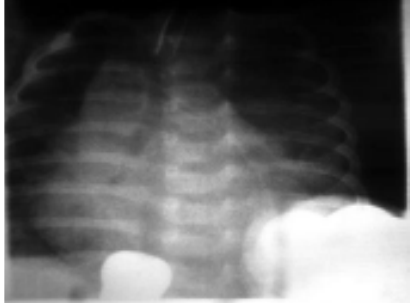
the right and left atria presented with equal pressures of 11 mmHg, hemodynamic improvement (80/40 mmHg to 100/60 mmHg) and oximetry (80% to 93%). The pulmonary branch was dilated, showing confluent pulmonary branches without stenosis. The venous return was abnormal via a common collector tube which emptied in the innominate and superior vena cava through a vertical vein, with a dilated route without signs of obstruction (Figure 2). The left atrium called our attention by presenting a reduced size, without limitations to contrast. No passage of contrast was seen to the right atrium.